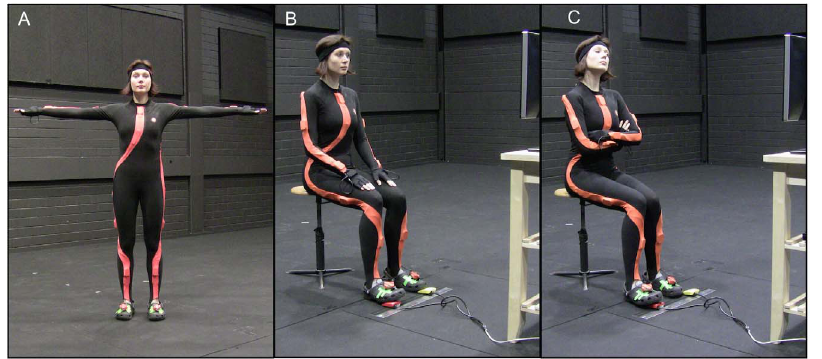
Figure 1. Setup for motion capture sessions. The individual in this figure has given written informed consent (as outlined in PLOS consent form) to publish the photo with the face unmasked. (A) An actor in motion capture Moven Xsens suit, t-pose (B) Acting setup: an actor in neutral pose, stool, pedals and display. (C) An actor expressing pride